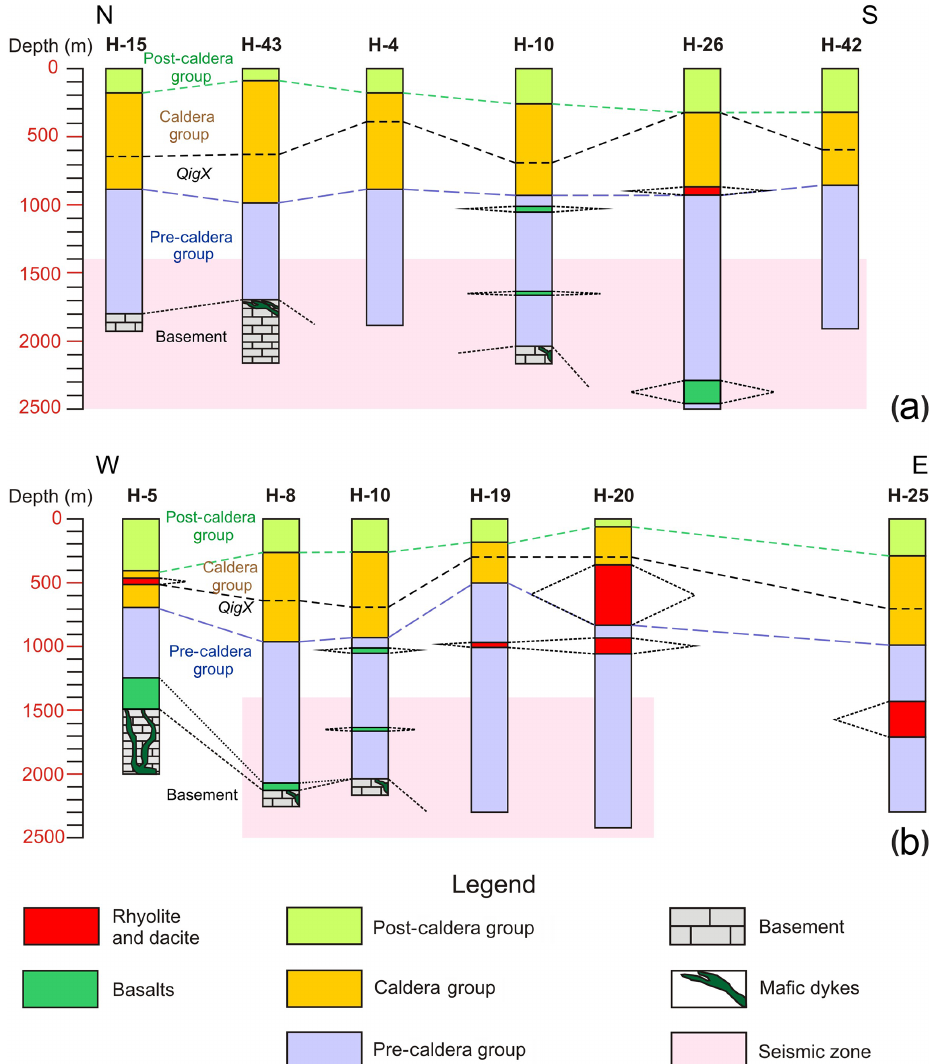
Figure 2. In-depth correlation of lithostratigraphic units along the N–S (a) and W–E (b) direction; redrawn after Carrasco-Núñez et al., (2017a) and Arellano et al. (2003). The ratio of depth to horizontal distance is 1 : 1. The location of the correlation line is shown in Fig. 1. QigX: Xaltipan